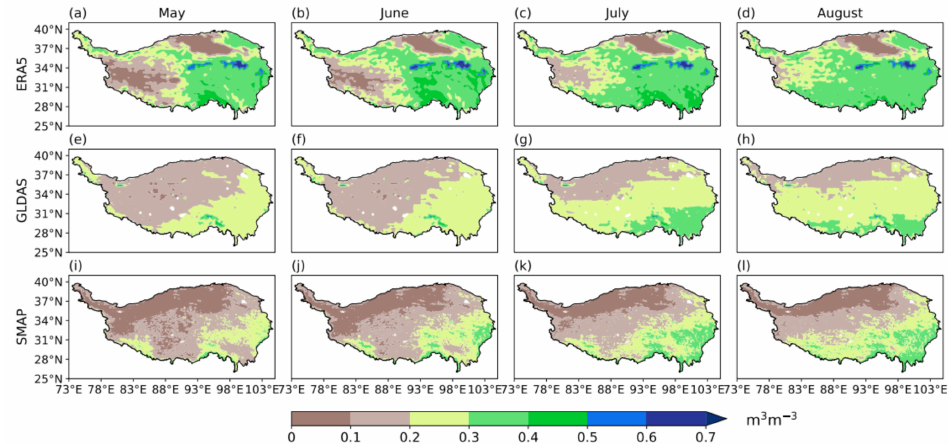
Figure 9. Spatial distribution of monthly average soil moisture derived from ( a – d ) the fifth-generation European Centre for Medium-Range Weather Forecasts atmospheric reanalysis (ERA5), ( e – h ) Global Land Data Assimilation System (GLDAS), and ( i – l ) Soil Moisture Active Passive (SMAP) datasets for May to August 2015–2021 over the Tibetan